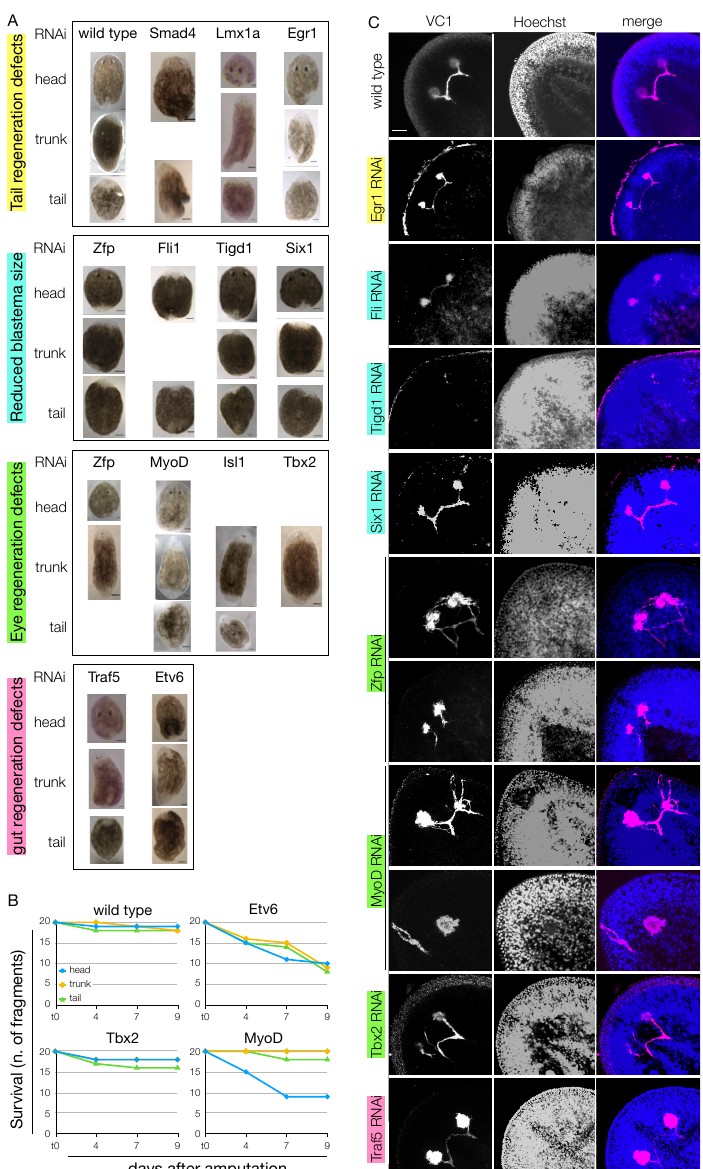
Figure 8. The knock-down of the blastema transcription factors resulted in regeneration defects. resulted in regeneration defects. The Knock-down of Smad4 , Lmh1a, and Egr1 resulted in tail regeneration defects (n = 7/9, 13/17, 17/24, respectively) and occasionally in eye regeneration defects (n = 3/9, 4/8, 20/43, respectively). The knock-down of Zfp , Fli1 , Tigd1 and Six-1 resulted in a blastema of a reduced size, regardless of the fragment considered (n = 32/42, 41/53, 11/19, 16/23, respectively). The Knock-down of Zfp , MyoD , Isl-1 and Tbx2/3 resulted in eye regeneration defects (n = 21/23, 26/26, 10/10, 9/13, respectively). The Knock-down of Traf5 and Etv6 resulted in gut regeneration defects and the formation of body-wide lesions (n = 14/16, 20/20, respectively). ( B ) In spite of the regeneration defects displayed, most of the knocked-down genes did not alter significantly the lethality rate; exceptions to this rule were Etv6 , with an average lethality of almost 50% at 9 dpa (n = 27/60) and MyoD , with a lethality rate >50% but limited to the head fragments (n = 48/60).